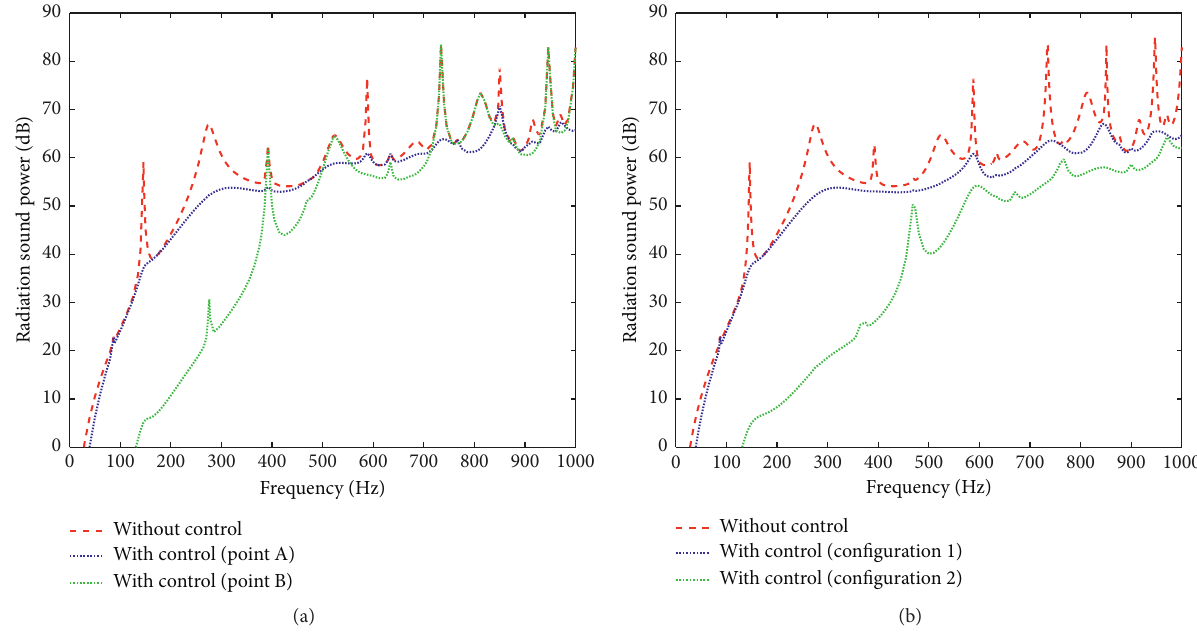
Figure 5: Effects of different positions and configurations of control force. (a) Single secondary control force. (b) Two secondary control forces.